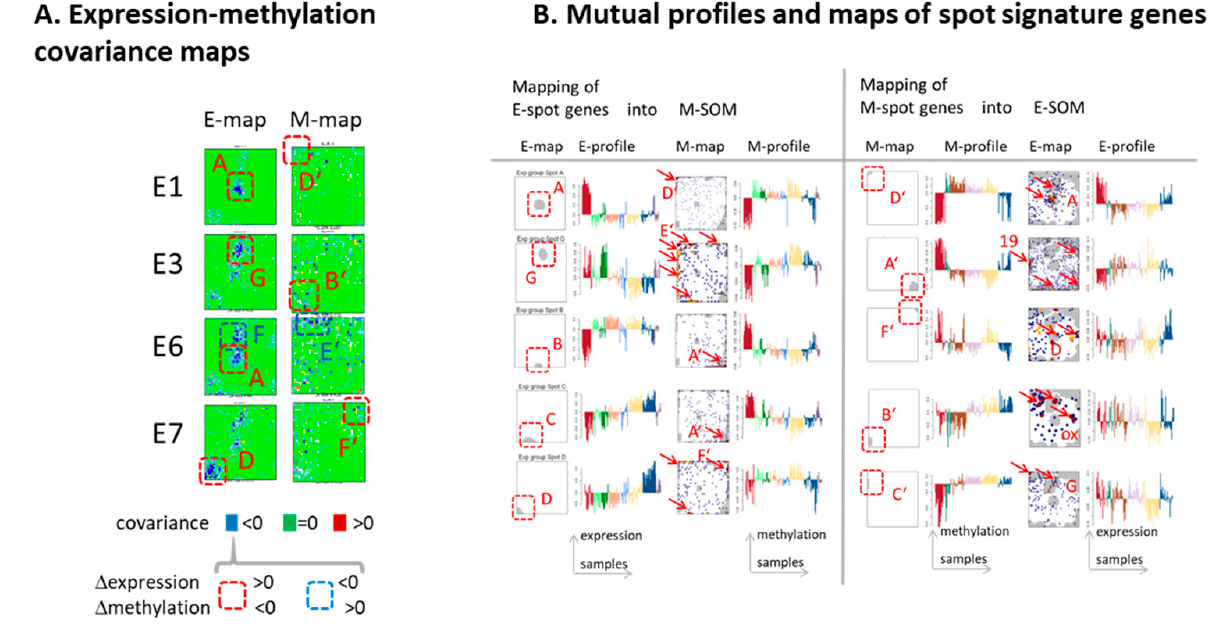
Figure 6. Relations between expression and methylation: ( A ) The covariance maps highlight genes co-regulated by mostly anti-correlated expression and methylation values. The frames mark selected spot areas where red and blue color assign opposite alterations of expression and methylation levels as indicated in the figure. ( B ) Mutual mapping of E- and M-spot genes (red frames) into the M- and E-SOM (arrows) indicates spot ‘melting’ and suggests divergence of genes related to distinct molecular mechanisms with respect to concerted transcriptional activation and methylation changes. Note that capital letters in the SOM-portraits assign spot